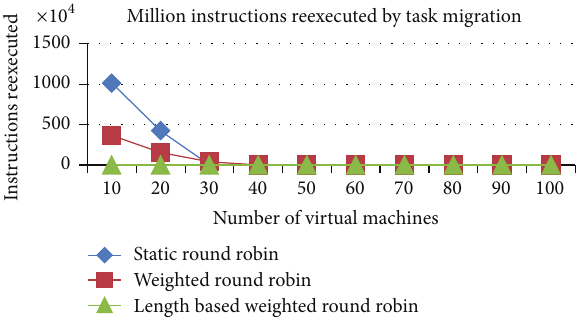
Figure 17: Million instructions reexecuted (time